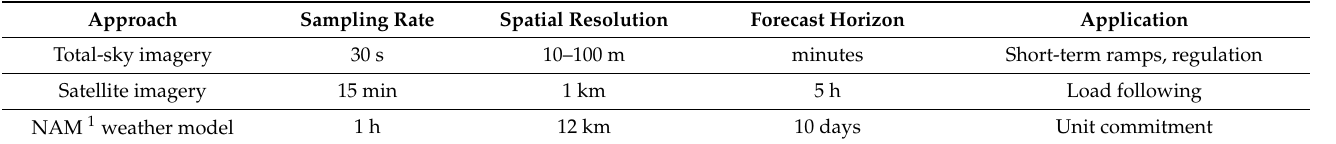
Table 1. Main characteristics and inputs for different solar forecasting approaches